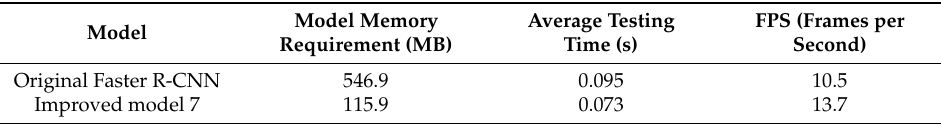
Table 3. Model parameter quantity and detection time.